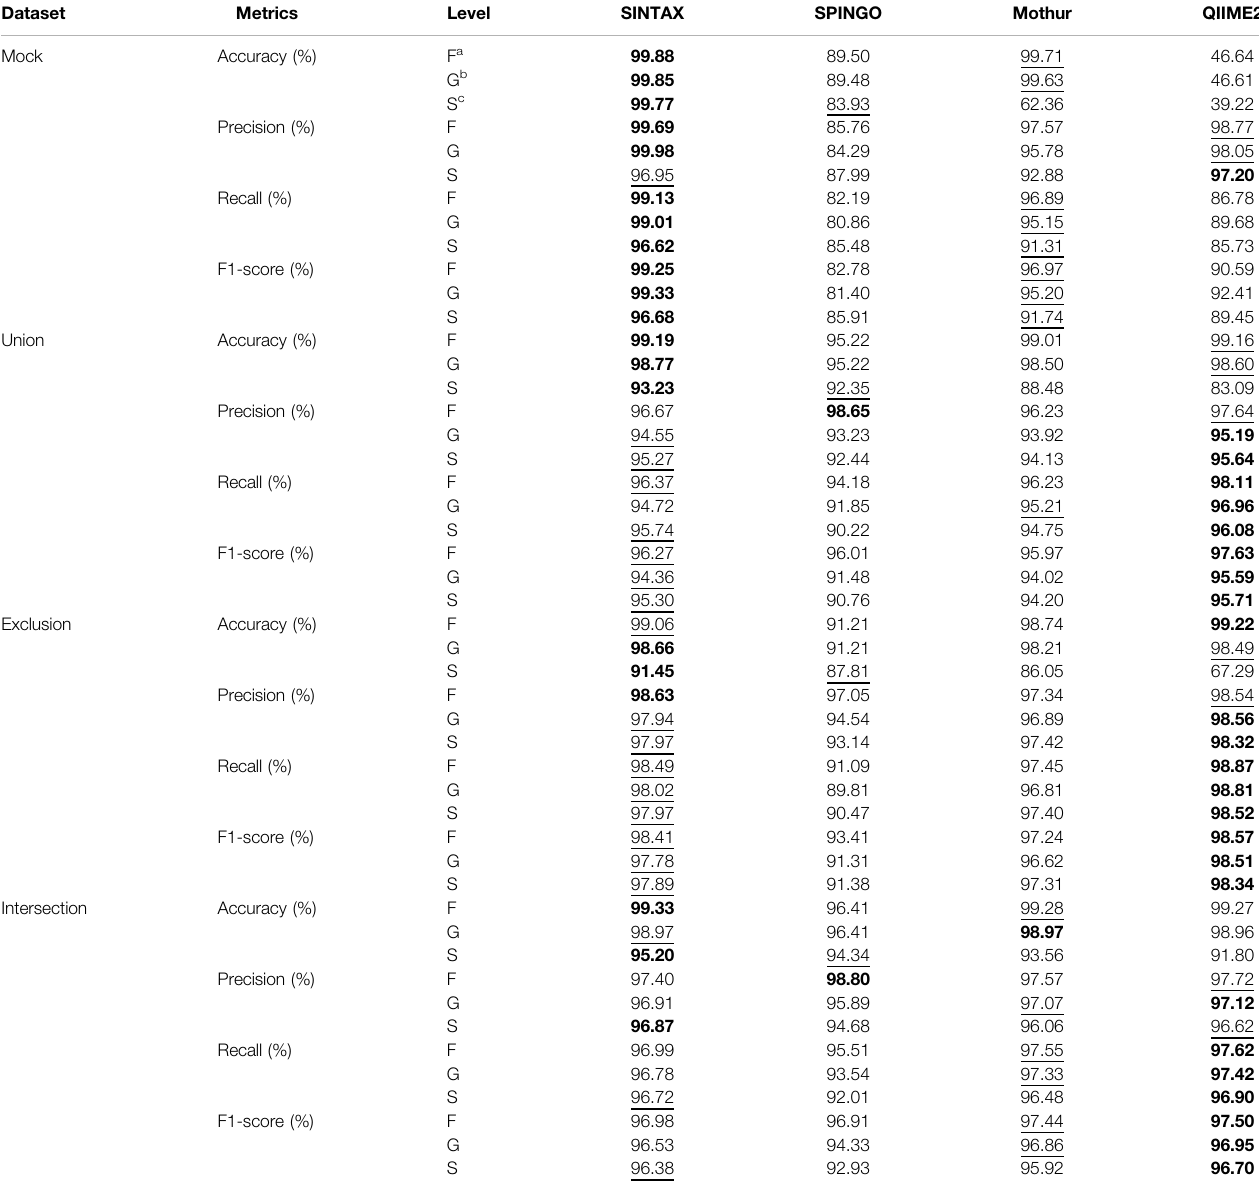
TABLE 3 | Performance comparison between different classi fi ers using the taxonomy-based integrated database. The bold font and underline symbol indicate the highest and the second highest value, respectively.